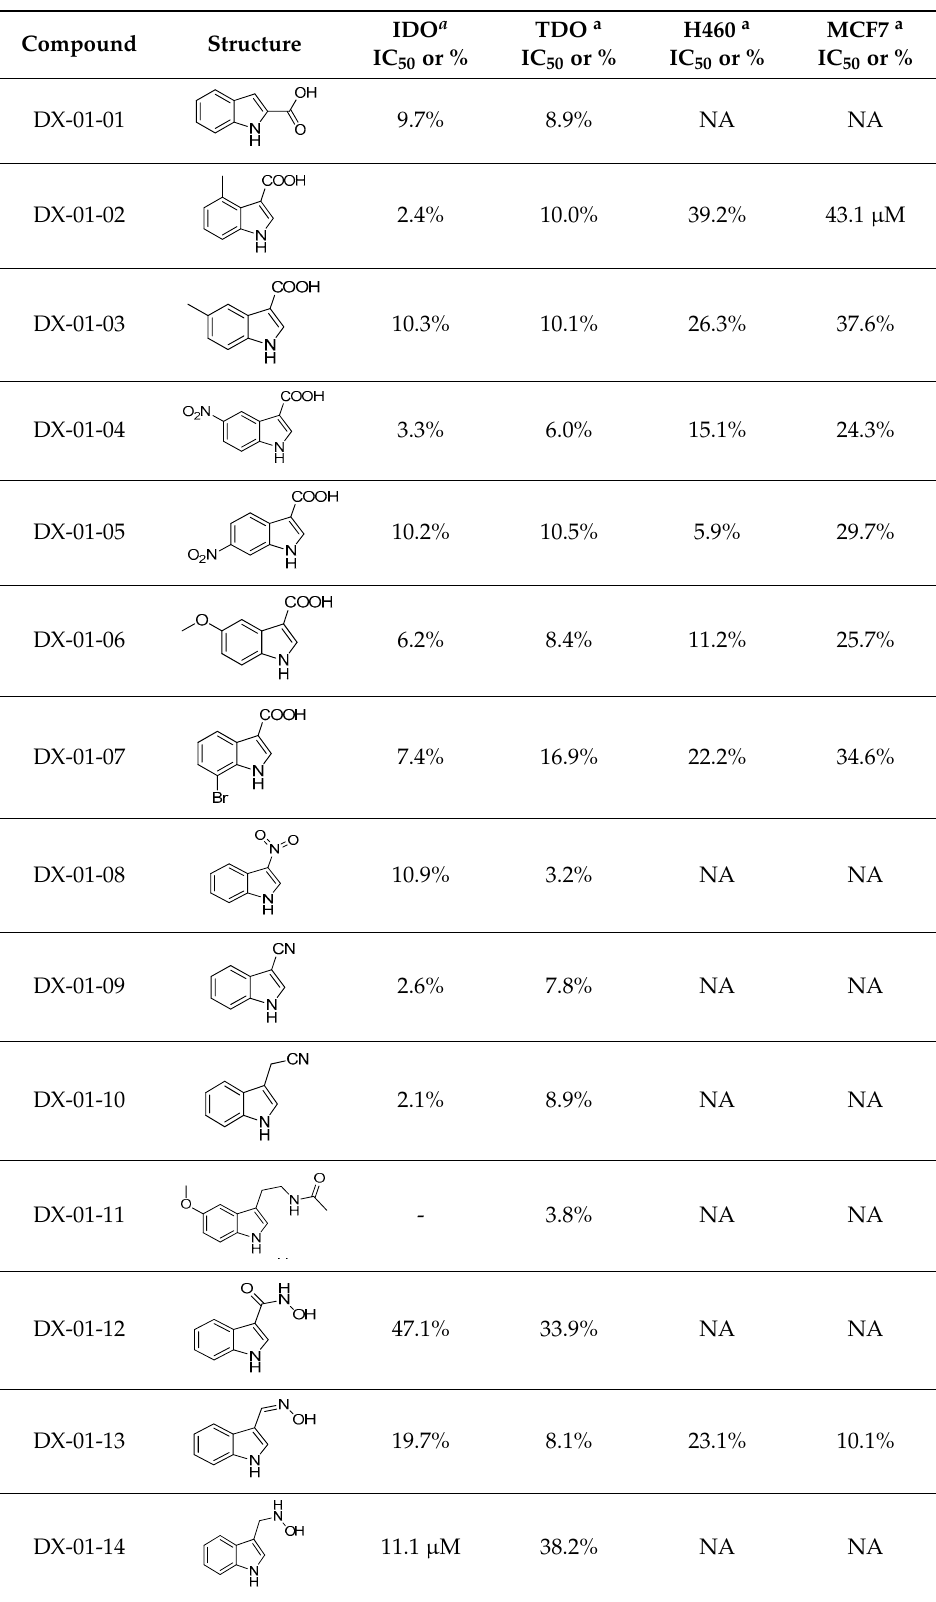
Table 1. In vitro IDO1 / TDO inhibitory activities and cell cytotoxicities of series 1. Table 1. In vitro IDO1/TDO inhibitory activities and cell cytotoxicities of series 1. Table 1. In vitro IDO1/TDO inhibitory activities and cell cytotoxicities of series 1. Table 1. In vitro IDO1/TDO inhibitory activities and cell cytotoxicities of series 1. Compound Compound Table 1. In vitro IDO1/TDO inhibitory activities and cell cytotoxicities of series 1. Compound Table 1. In vitro IDO1/TDO inhibitory activities and cell cytotoxicities of series 1. Compound Table 1. In vitro IDO1/TDO inhibitory activities and cell cytotoxicities of series 1. Compound Table 1. In vitro IDO1/TDO inhibitory activities and cell cytotoxicities of series 1. Compound Table 1. In vitro IDO1/TDO inhibitory activities and cell cytotoxicities of series 1. Compound Table 1. In vitro IDO1/TDO inhibitory activities and cell cytotoxicities of series 1. Compound Table 1. In vitro IDO1/TDO inhibitory activities and cell cytotoxicities of series 1. Compound Table 1. In vitro IDO1/TDO inhibitory activities and cell cytotoxicities of series 1. Compound Table 1. In vitro IDO1/TDO inhibitory activities and cell cytotoxicities of series 1. Compound Table 1. In vitro IDO1/TDO inhibitory activities and cell cytotoxicities of series 1. Compound Table 1. In vitro IDO1/TDO inhibitory activities and cell cytotoxicities of series 1. Compound Compound